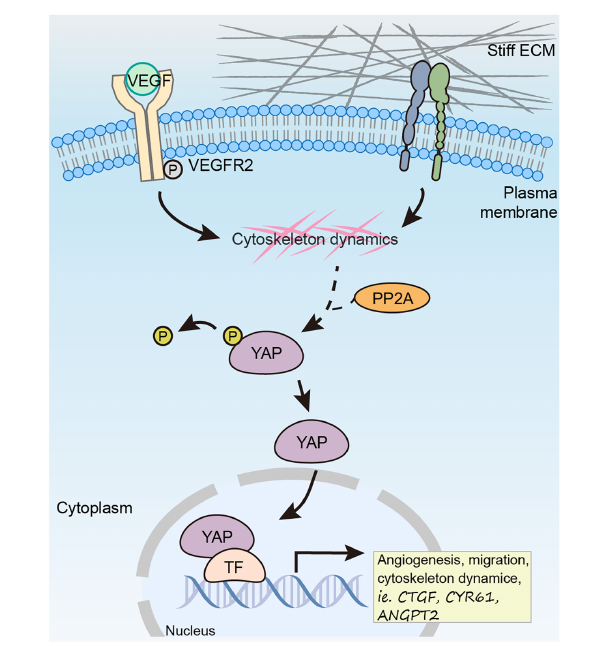
FIGURE 7 | Working model showing PP2A mediates dephosphorylation of YAP in response to VEGF and high stiffness to promote angiogenesis in